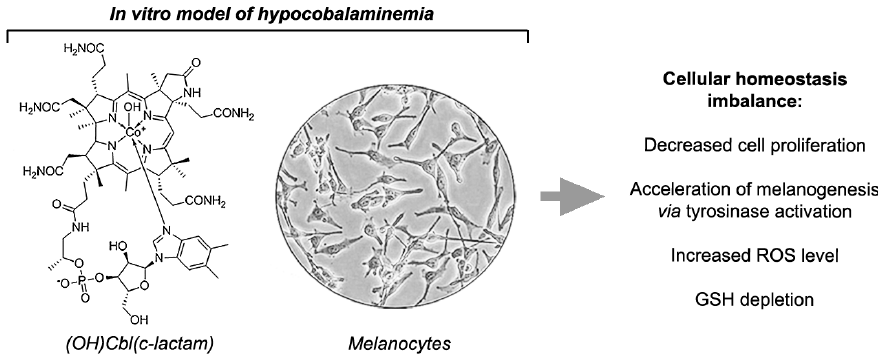
Figure 6. Schematic presentation of the main findings from the study.